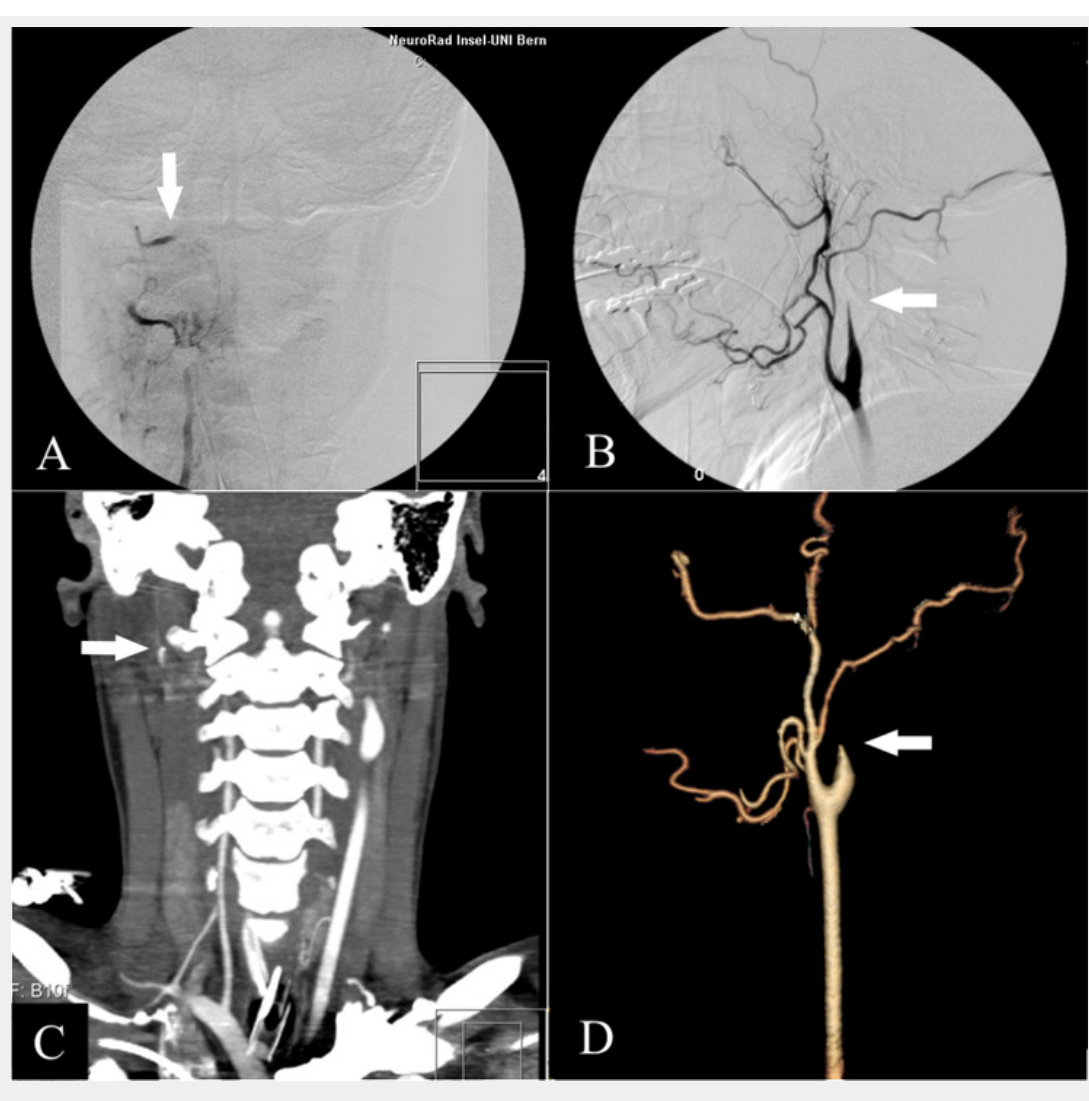
“Gold Standard” DSA: AP view of the right vertebral artery (A) and lateral view of the right carotid artery (B). The stop of contrast in the intersection between extra- and intradural segment of the vertebral artery and the cervical segment of the internal carotid artery are typical angiographic findings (white arrows); in DSA, they are rated as proof of cerebral circulatory arrest. From the axial CT-Dataset similar views as DSA can be obtained in 2D- (C; vertebral artery) or 3D-reformations (D; carotid artery). For the evaluation of brain death we only use the axial source images. Doing reformations is time consuming, operator dependent and not established in the literature for the determination of brain death. They are shown here only for exemplary purposes and nicely illustrate the lack of intracranial blood